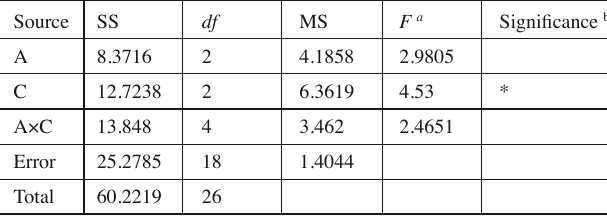
Tab. 6: Results of variance (ANOVA) analysis for C . vulgaris